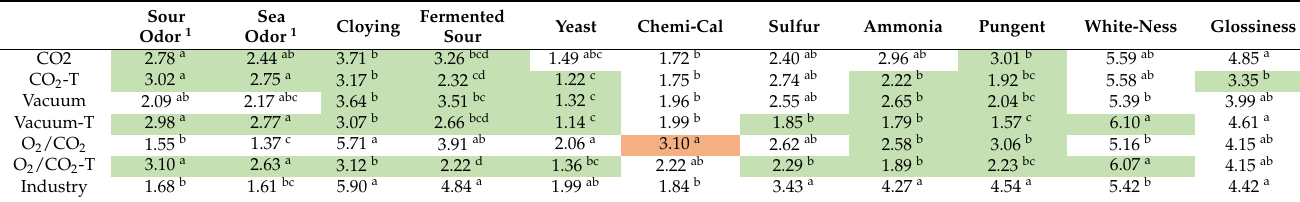
Table 4. Sensory scores of odor attributes (1 = low intensity, 9 = high intensity) after 13 days of storage (2 ◦ C). For each column, entries with the same letter attached to them are not significantly different at the 0.05